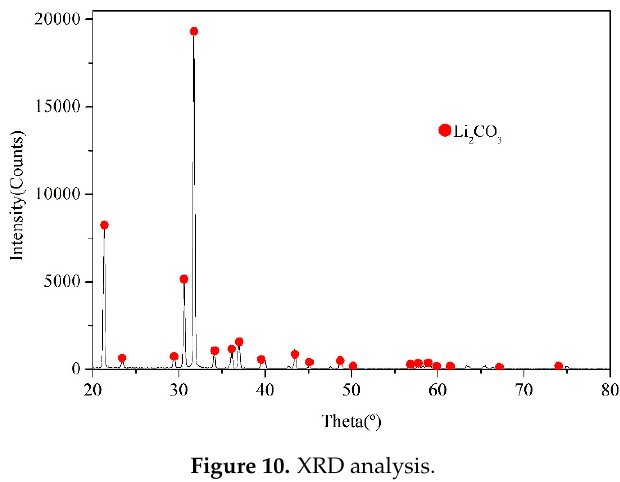
Figure 9. The yields and purities of the heating rate with resin.